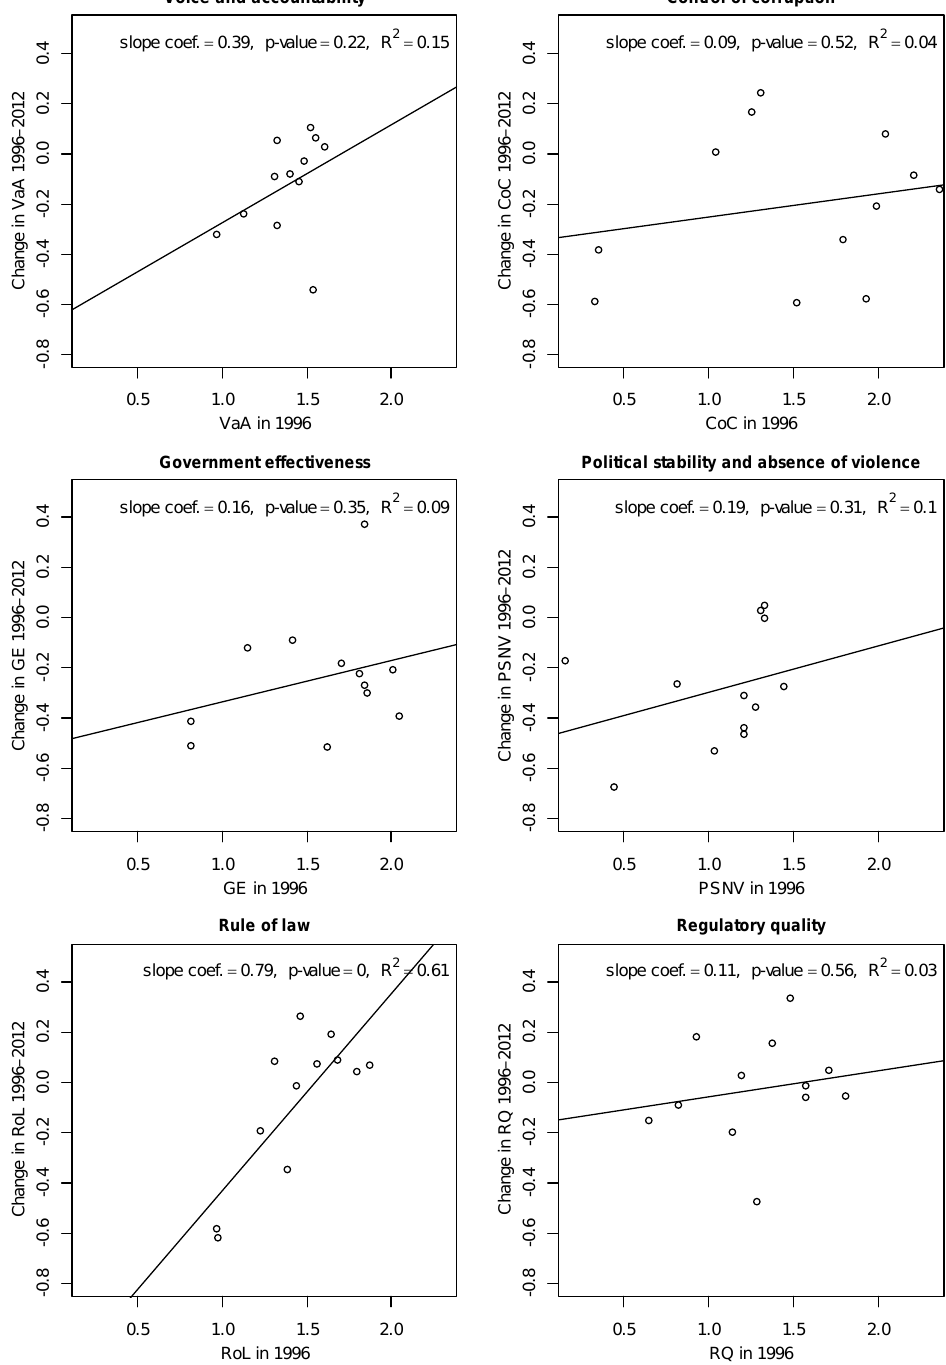
Figure 6 : WGIs’ β -convergence in the euro area of the first twelve